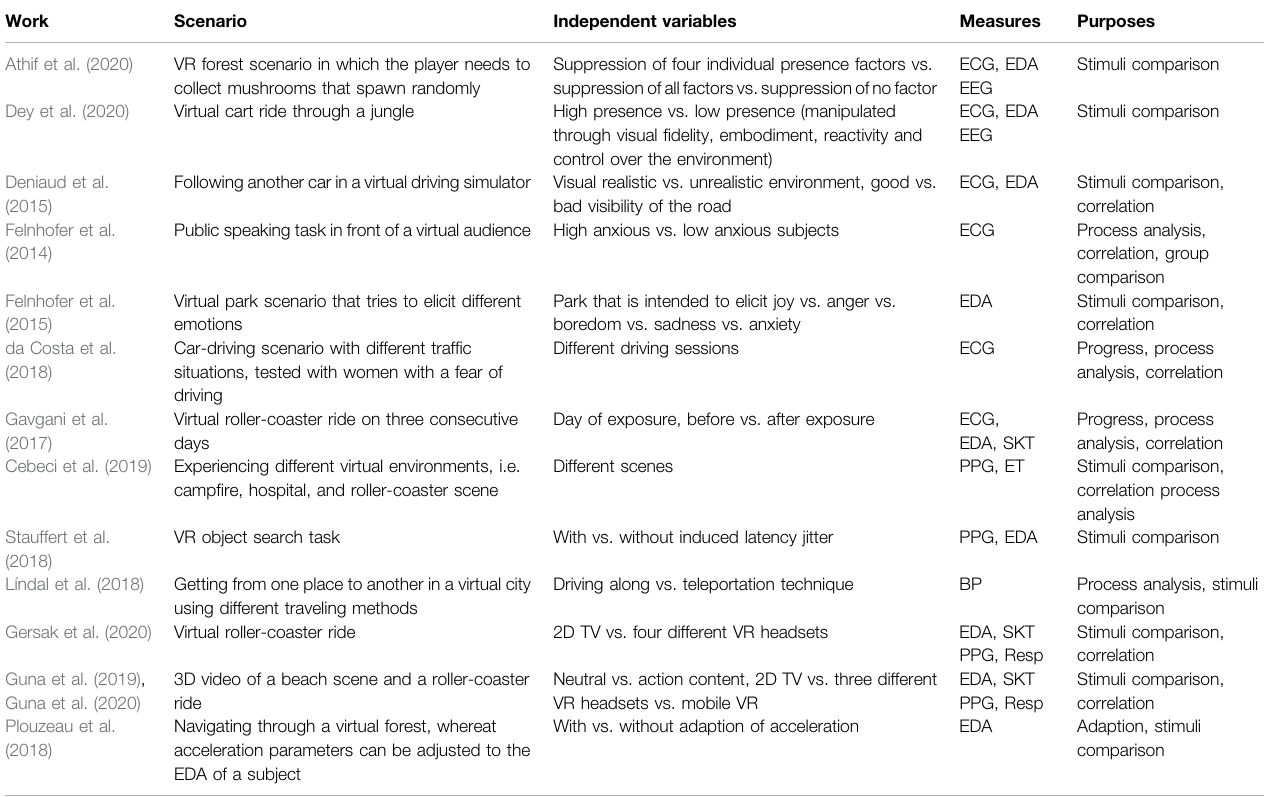
TABLE 9 | Overview of the works from the fi eld of general VR properties that were discussed in Section 4.1.5 . The Measures column refers to the physiological measures usedinthework.TheentriesoftheIndependentVariablescolumnoftendonotcovereverythingthatwasconsideredinthework.EntriesinthePurposescolumnreferto the categories listed in Section 4.1.6